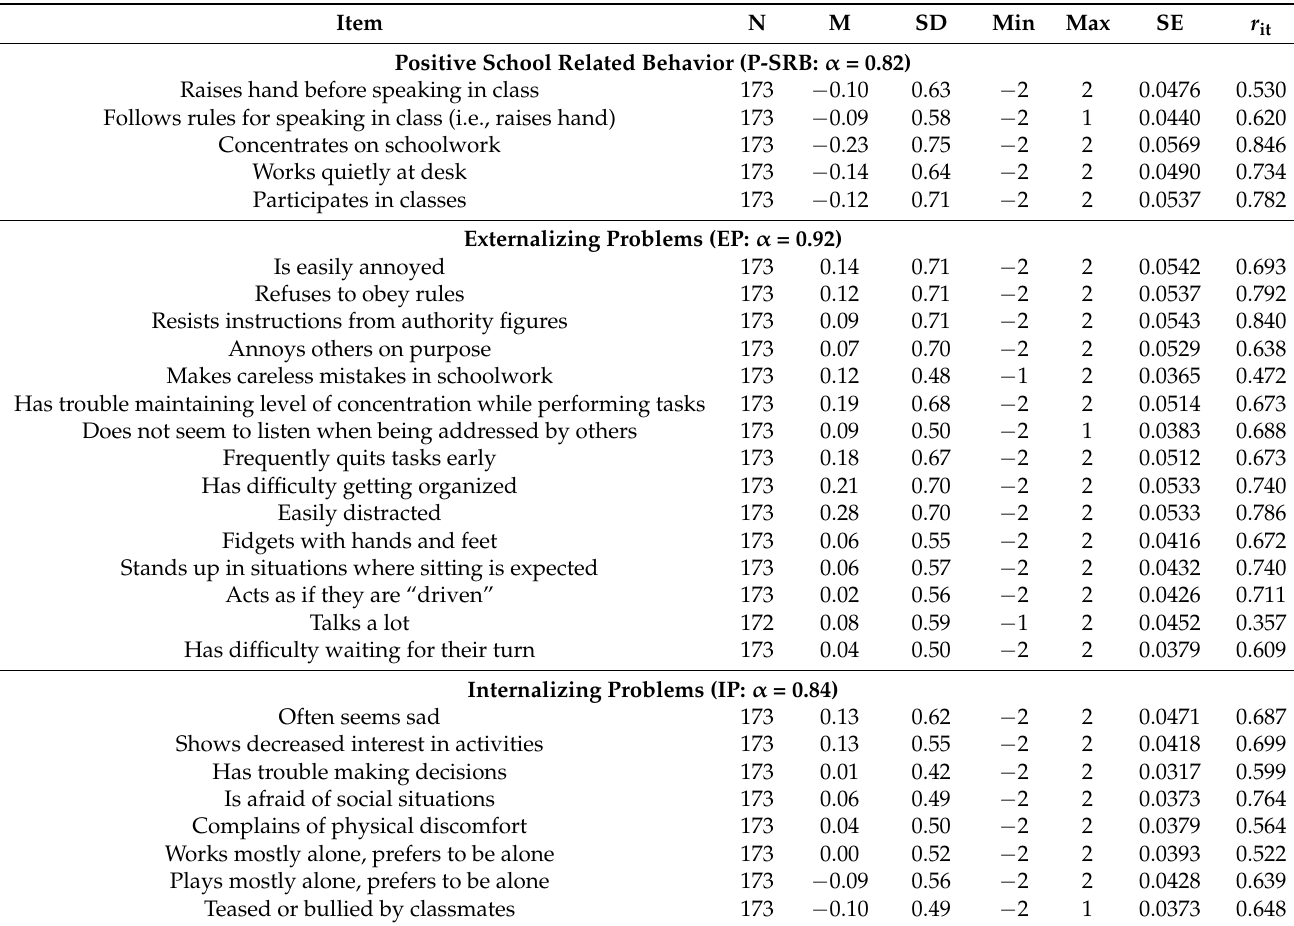
Table A2. Item and scale properties of the measurements for the lockdown effect on EP, IP, and P-SRB. Item